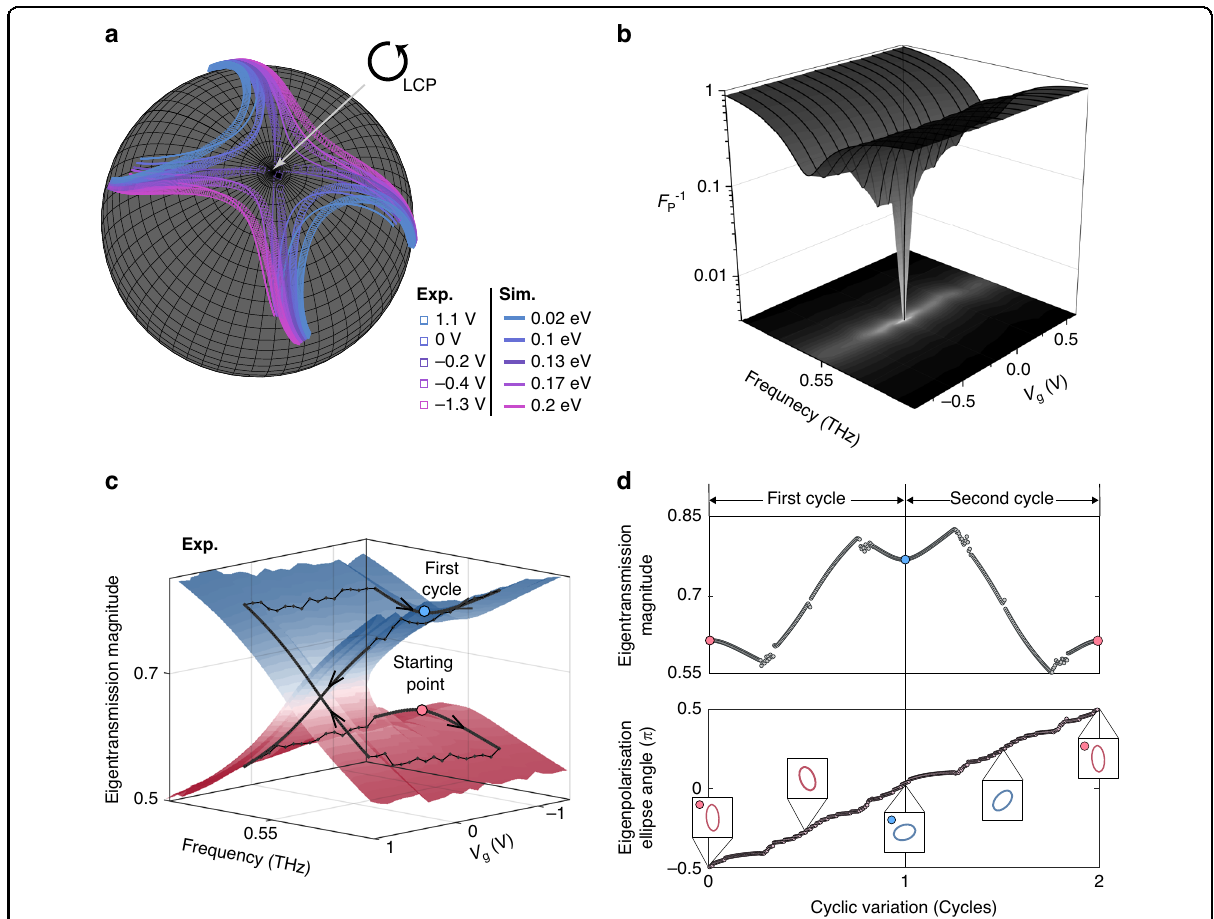
Fig. 3 Electrical access to eigenpolarisation states at the EP. a Experimentally-extracted (drawn with squares) and numerically-simulated (drawn with lines) eigenpolarisation states are parametrically plotted on the Poincare ́ sphere. Note the LCP corresponds to the south pole. b Inverse Petermann factor ( F (cid:2) 1 ) estimated from the experimentally-extracted eigenpolarisation states. c Cyclic parameter variation (drawn with a black line) p around the chiral EP on the measured Riemann surface of eigentransmission magnitude. The red dot indicates the starting point for the fi rst cyclic variation on the parameter space, while the blue dot denotes the starting point for the second cyclic variation. d Experimentally-extracted eigentransmission magnitude (top) and the corresponding eigenpolarisation ellipse angle (bottom) along an encircling path on the Riemann surface around the chiral